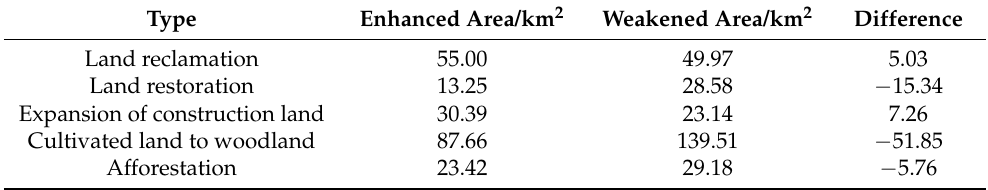
Table 5. Land use type transition matrix of regions with changes in spatial